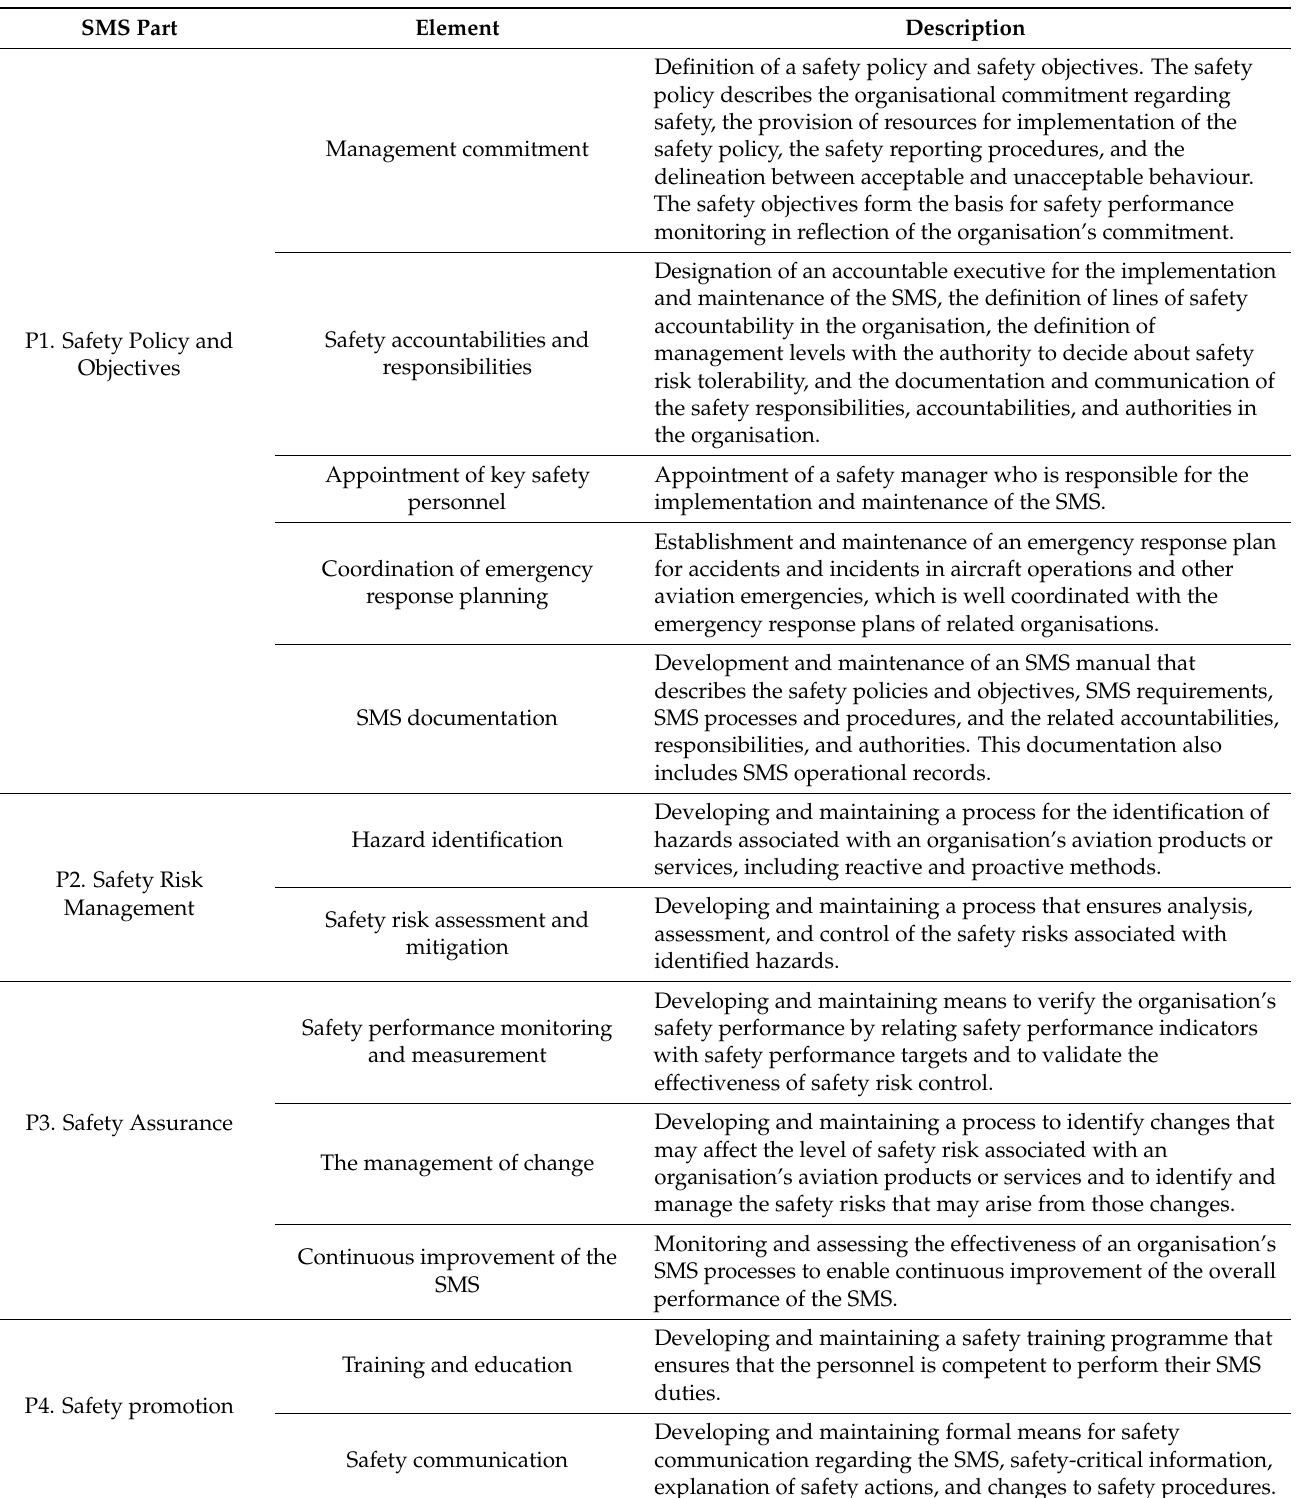
Table 1. SMS parts in ICAO SARPs